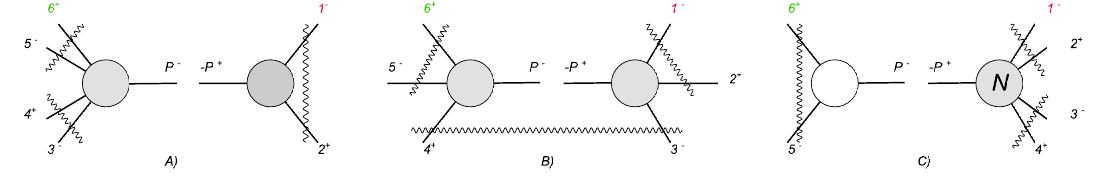
Figure 2 . The off-shell BCFW contributions representing A ∗ external momenta. The first and the third terms labeled A) and C) are type C and D contributions, while the second, labeled B), term is type B contribution of the off-shell BCFW recursion (3.6).